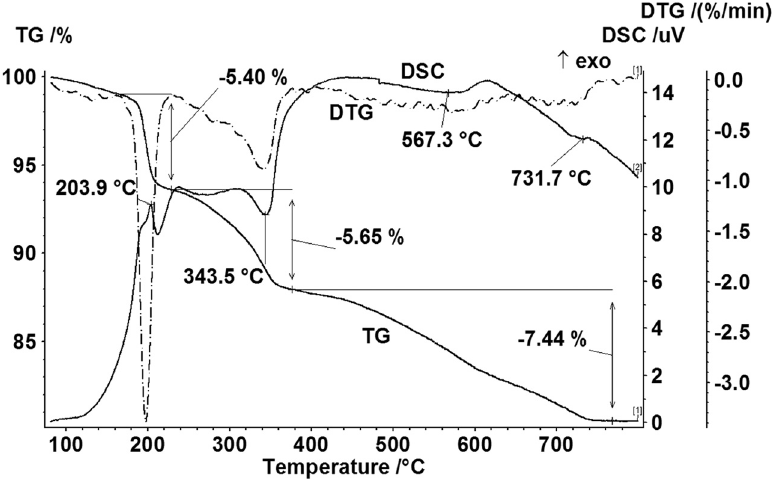
Figure 2: Thermal curves of the initial LCO - 1 sample in air.